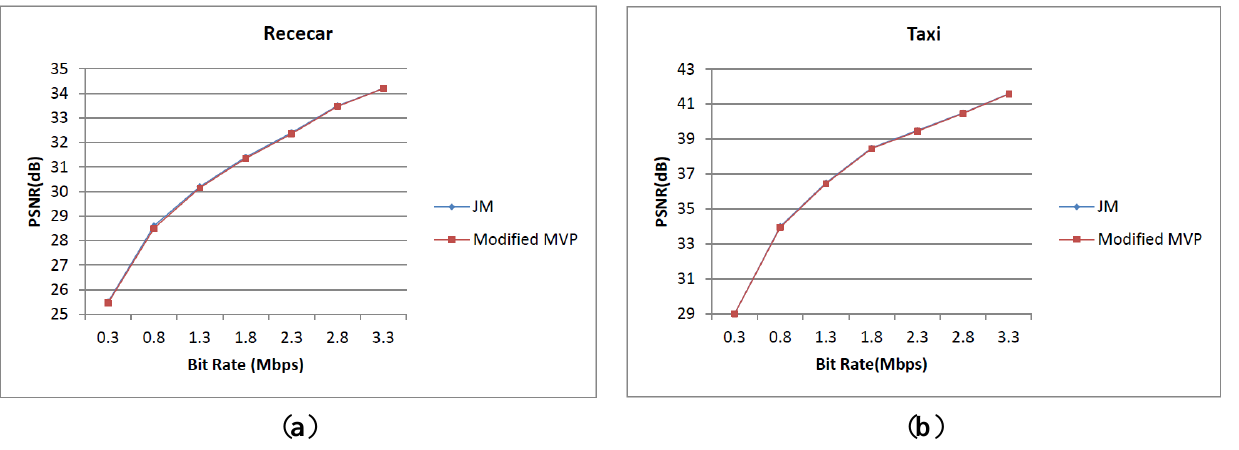
Figure 24. Comparison of RD curves between JM and modified motion vector prediction. ( a ) The comparison between JM and modified motion vector prediction in Racecar; ( b ) The comparison between JM and modified motion vector prediction in